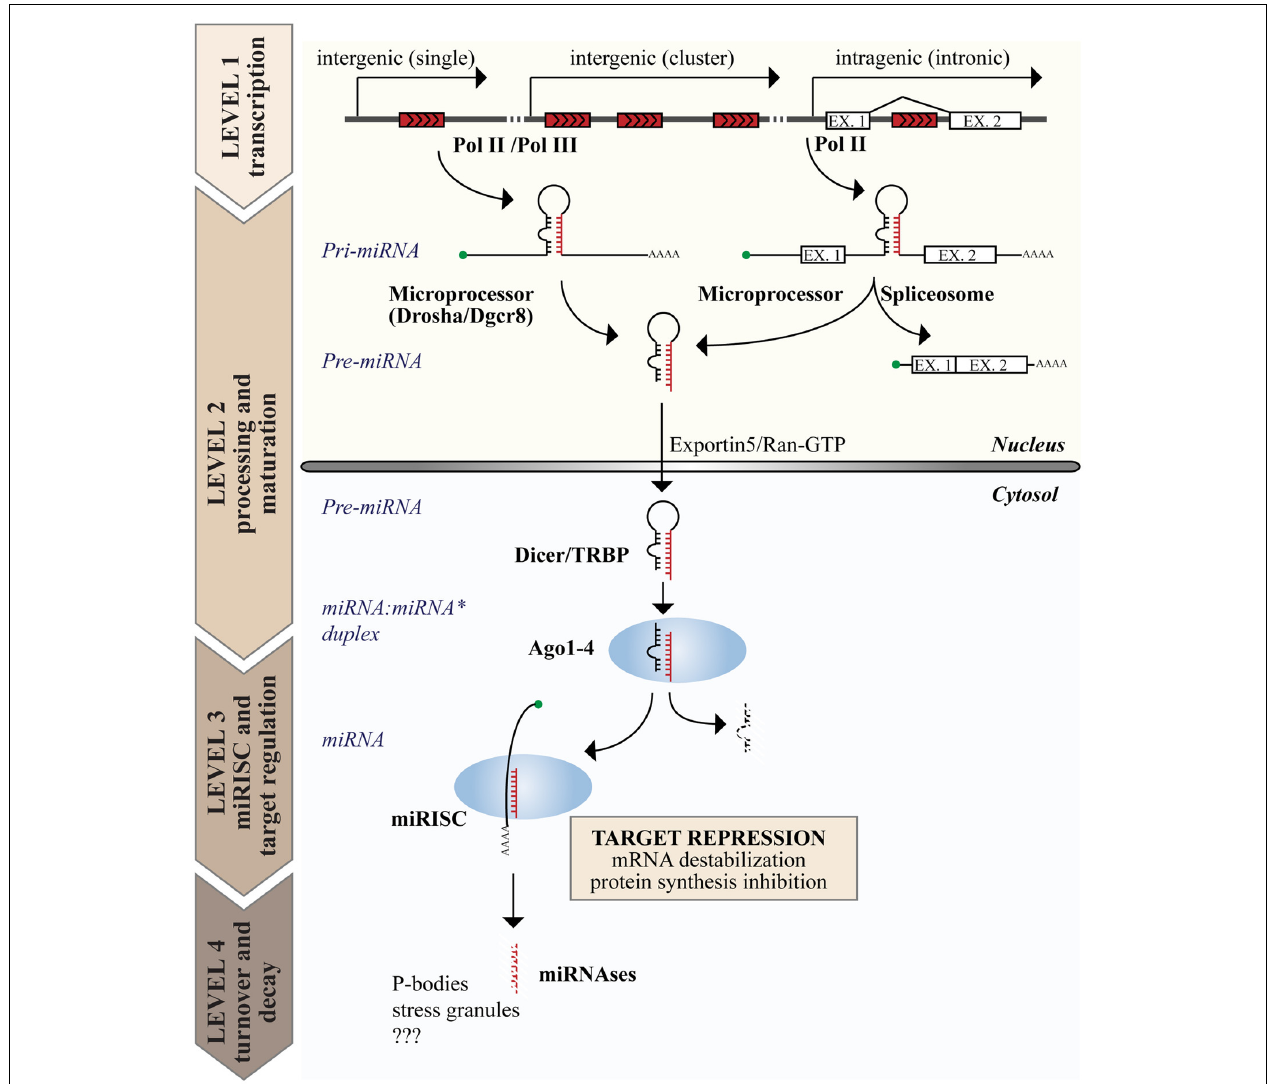
cytoplasmic processing, loading into the miRISC complex, and the degradation of mature miRNAs.The function of miRNAs is exerted in the cytosol at the level of the miRISC, where miRNAs induce target gene repression by various mechanisms, including inhibition of protein synthesis and mRNA